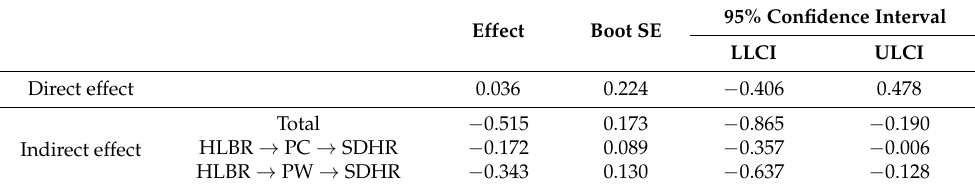
Table 8. Mediating-effect test